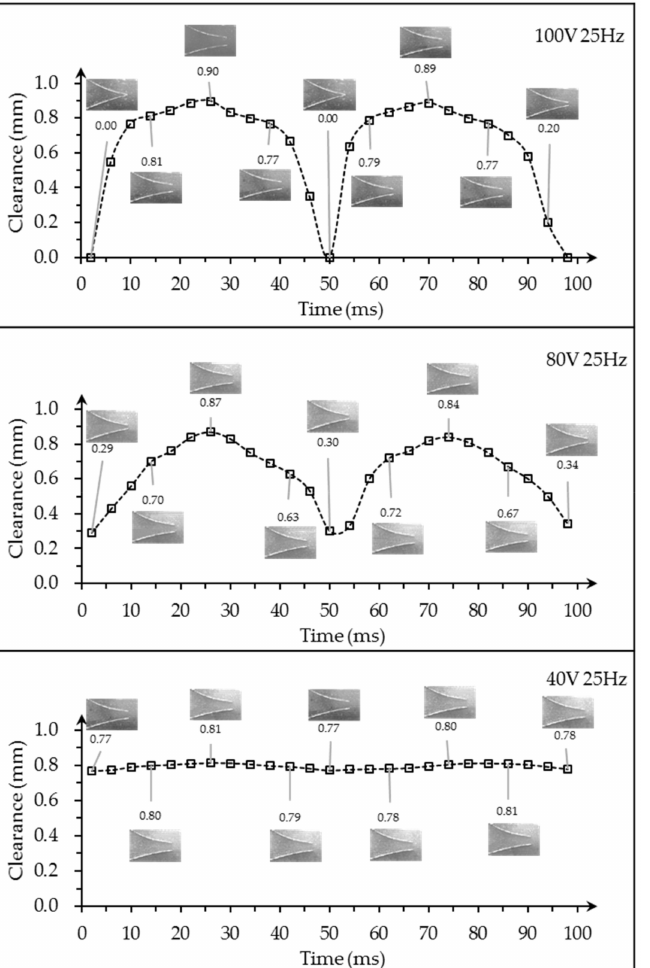
Figure 14. The observed clearance between the two leaflets in one